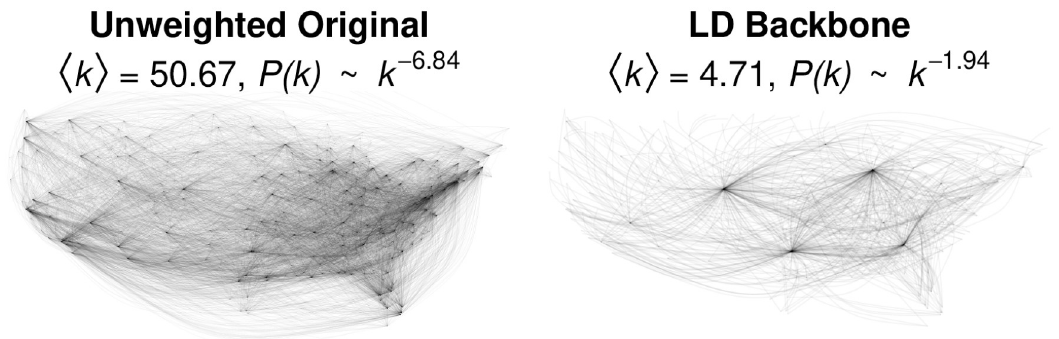
Fig 9. Extracting the backbone of an unweighted network of continental US airline traffic in